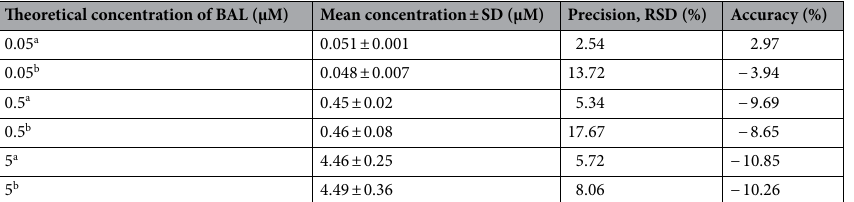
Table 4. Results of the within and between-run precision and accuracy evaluation for the analysis of balenine in plasma. a within-run analysis (n = 6; on 3 separate days); b between-run analysis (n = 2; on 3 separate days); SD Standard deviation, RSD Relative standard